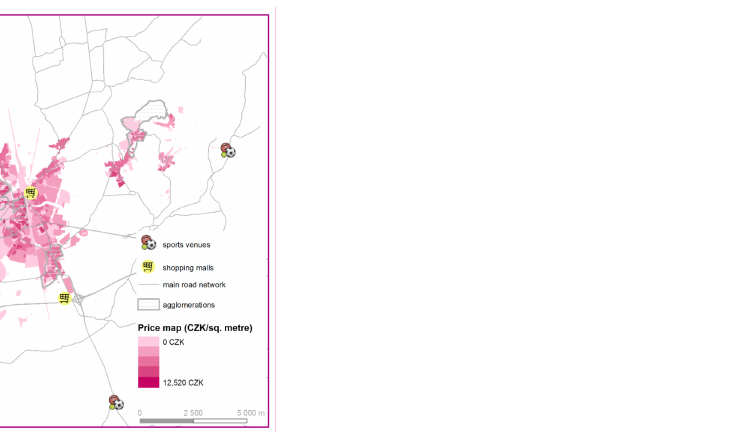
Figure 3. A gaming location with price map and bonus site allocations used for the start-up round. Source: